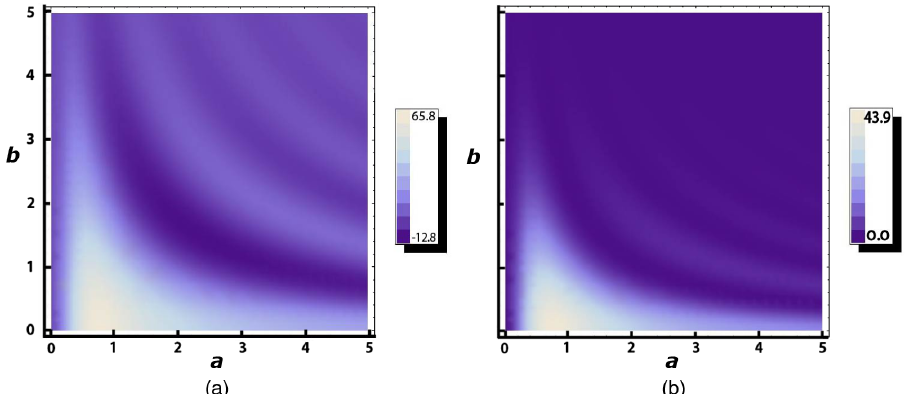
1 Þ 0 ; 0 Þ and (b) − S ð 2 Þ 0 ; 0 Þ , for m ¼ 3 . Both are zero when a ¼ b ¼ 0 reaches a 12 ð a; b; a; b; 12 ð a; b; a; b;